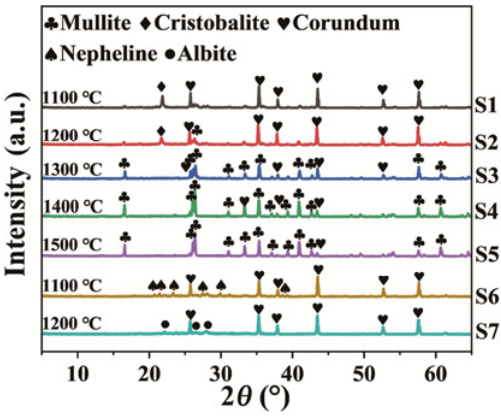
Fig. 9 XRD patterns of ion-exchanged (S1–S5) and non-ion-exchanged (S6 and S7) samples at different sintering temperatures.